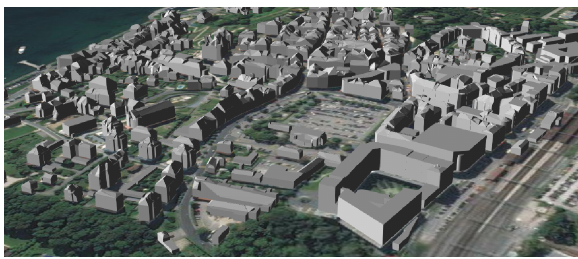
Figure 6. Automatically generated buildings for the city of Nyon automated methods are an important tool for the generation of this